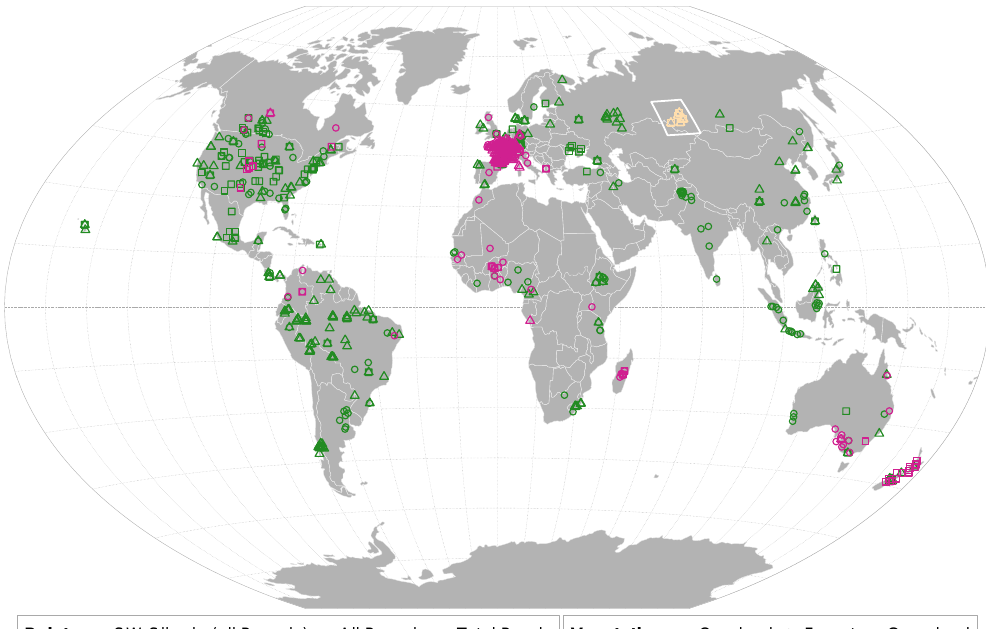
Figure 1. Location of the study sites (south-western Siberia is outlined by the white box; data points are beige) and the data points from a literature compilation. Distinction is made between the quantity of information available for each point (colour) and between vegetation cover (shape). “All P pools” stands for total P, organic P, inorganic P, phosphate ions in soil solution, diffusive phosphate ions and isotopically exchangeable phosphate ions. Winkel tripel projection; graticules 15 ◦